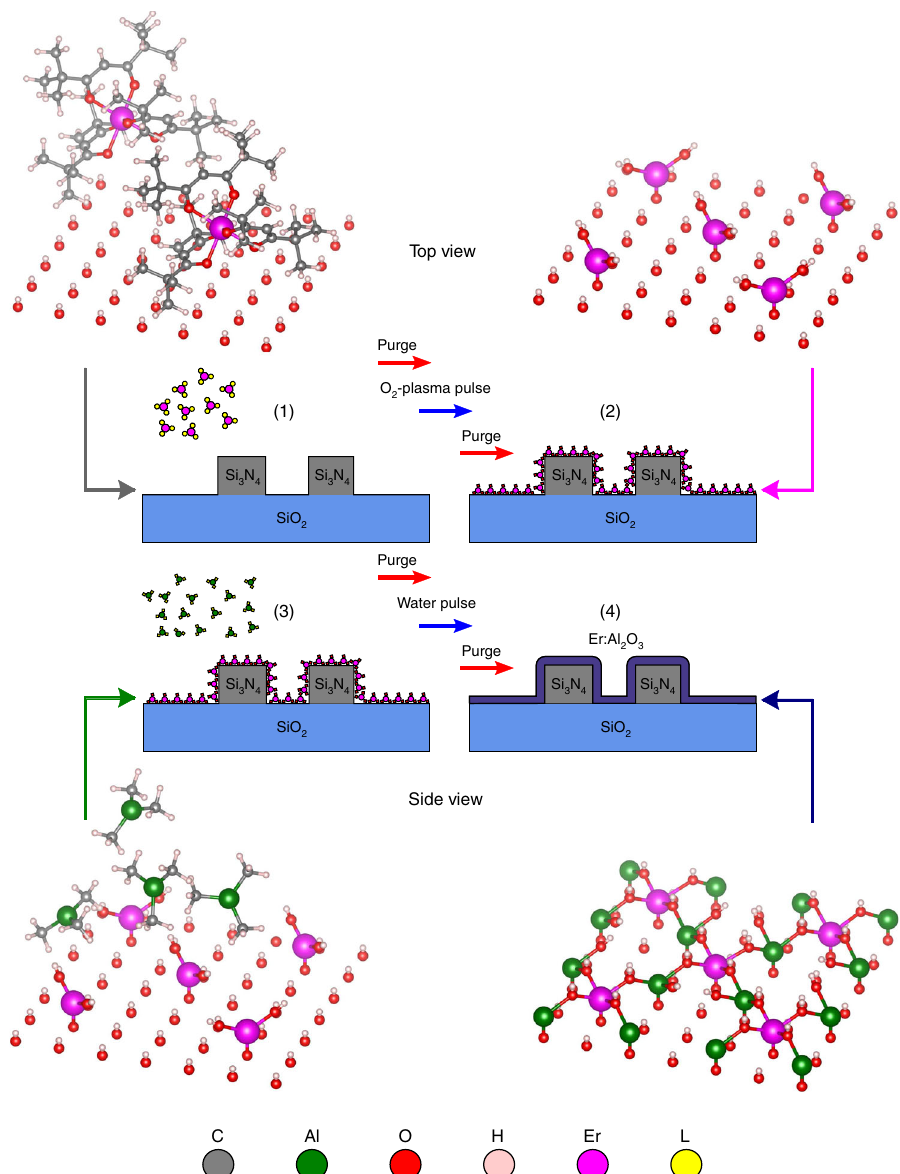
Fig. 2 ALD-process sequence for the Er 2 O 3 – Al 2 O 3 supercycle: (1) Er(thd) 3 pulsing on the preprocessed Si 3 N 4 slot waveguide. (2) Resulting device layer after nitrogen purging, oxygen plasma pulsing, and nitrogen purging. (3) TMA-pulsing on the Er 2 O 3 – Si 3 N 4 surface. (4) Resulting device layer after nitrogen purging, water pulsing, and nitrogen purging. The colors for the individual atoms/molecules are as follows: C: gray; Al: green; O: red; H: white; Er: magenta; thd/methyl ligand (L):